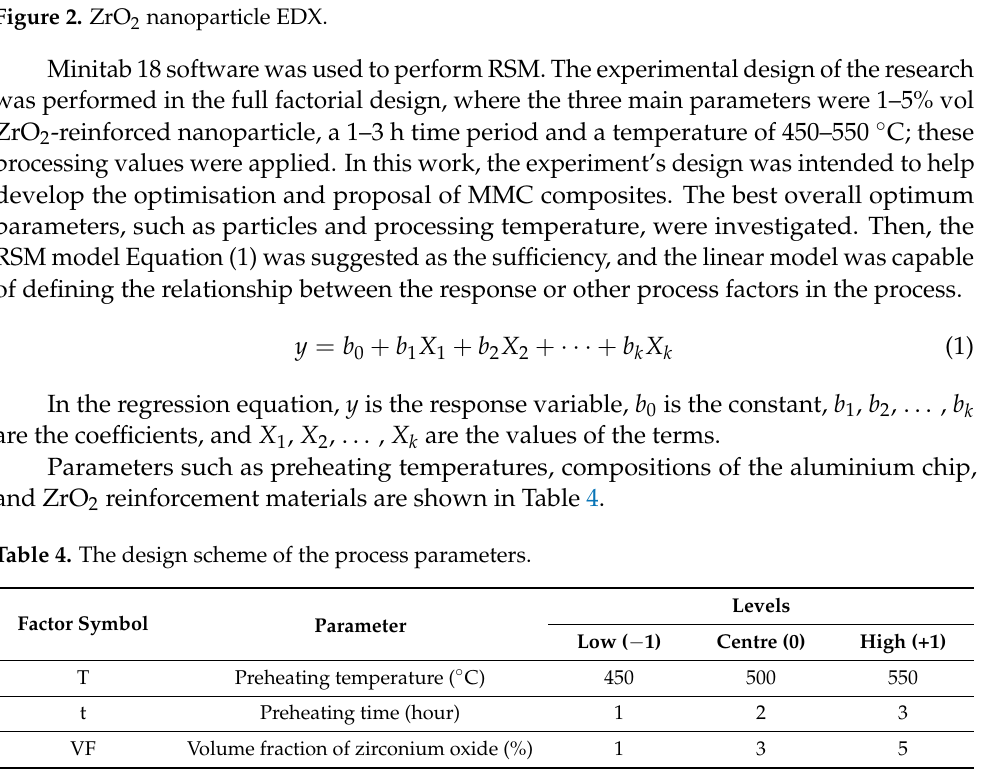
Figure 2. ZrO 2 nanoparticle EDX.